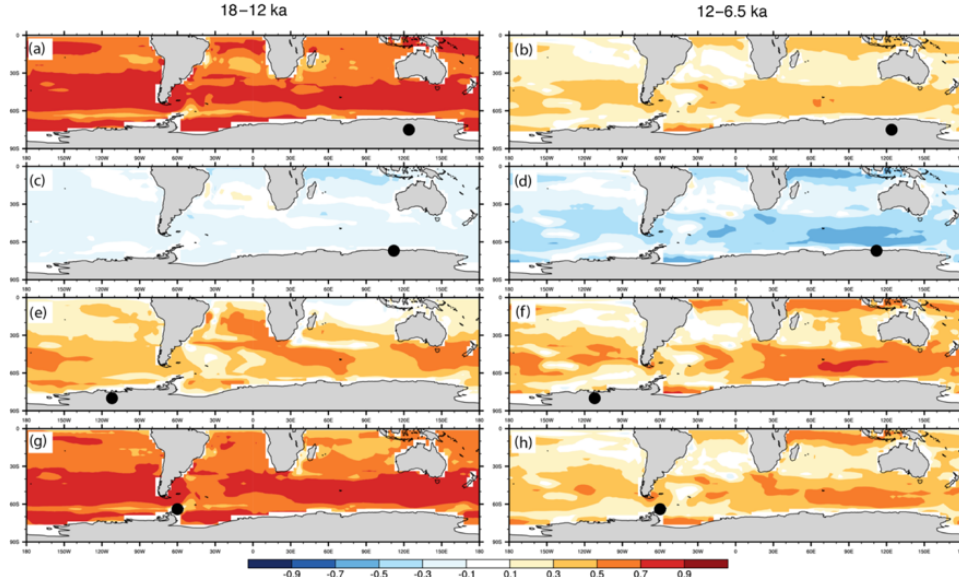
Figure 12. Spatial Pearson linear cross-correlation coefficients ( r ) between decadal SST and precipitation of the DG ns simulation for (a, c, e, g) 18–12ka and (b, d, f, h) 12–6.5ka at the (a, b) EDC (73–77 ◦ S, 121–127 ◦ E), (c, d) LD (65–70 ◦ S, 110–116 ◦ E), (e, f) WDC